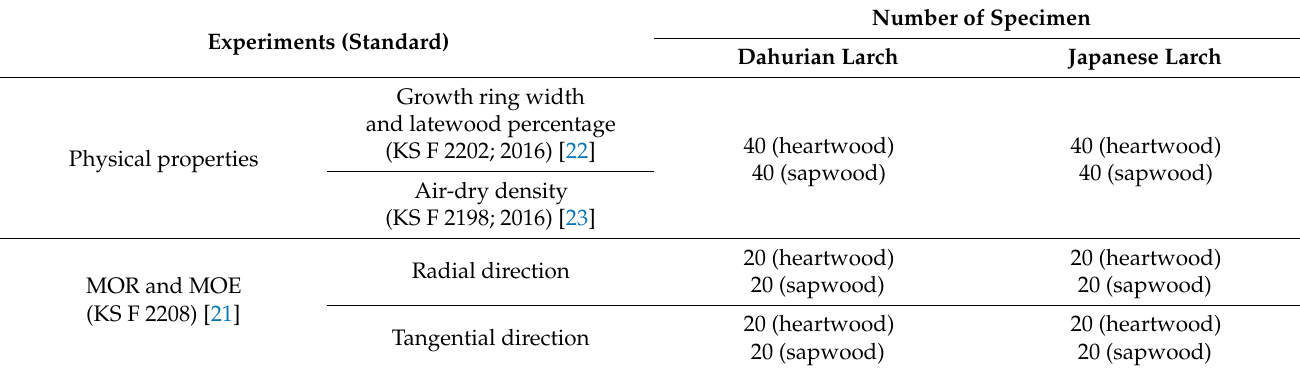
Table 2. Number of specimens for each